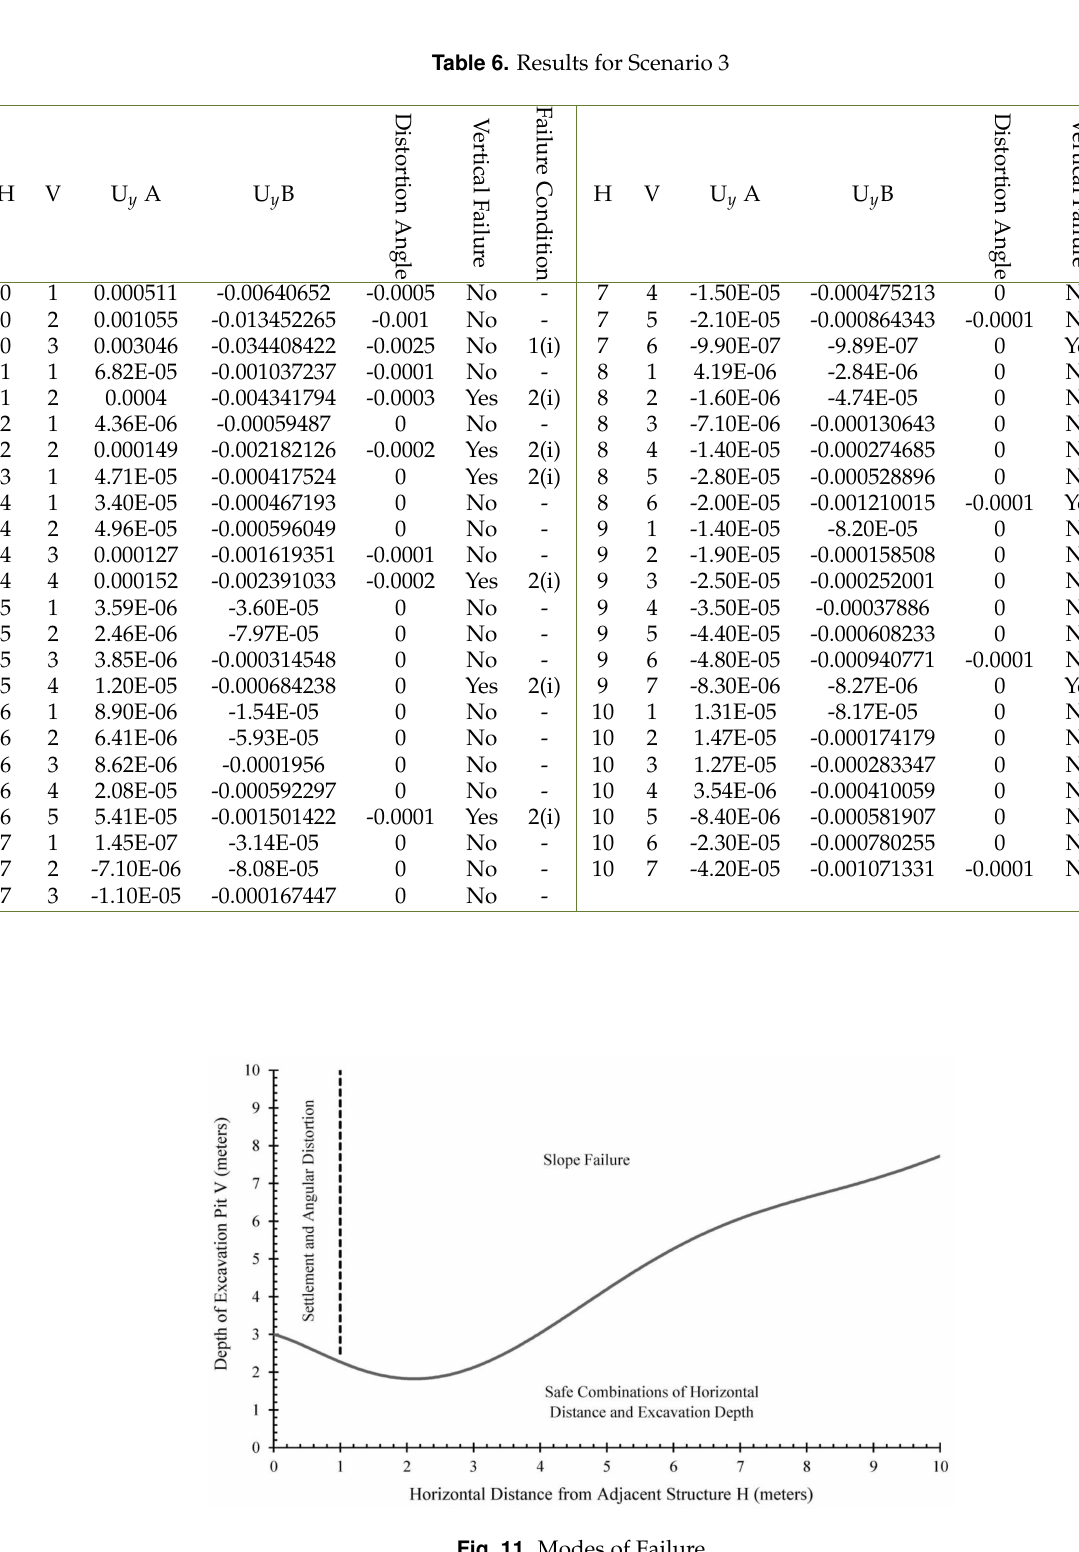
Fig. 11. Modes of